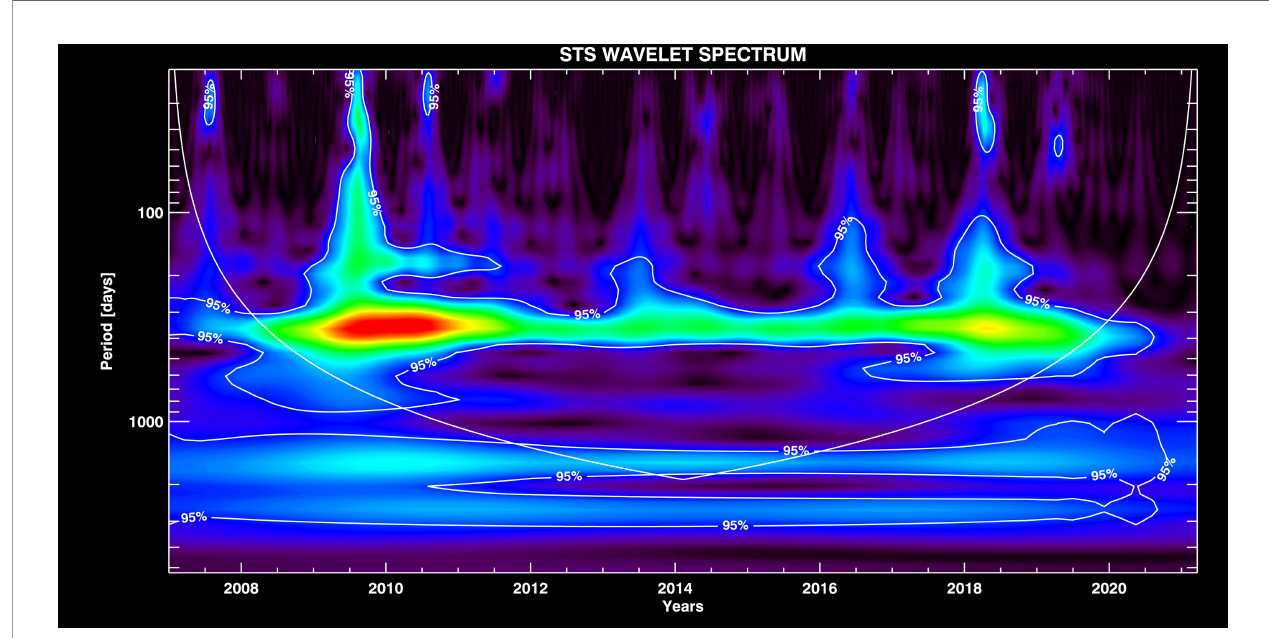
FIGURE 4 | WT of the STS signal with overplotted contours of the signi fi cance interval of 0.95 %, and the con fi dence interval (COI)